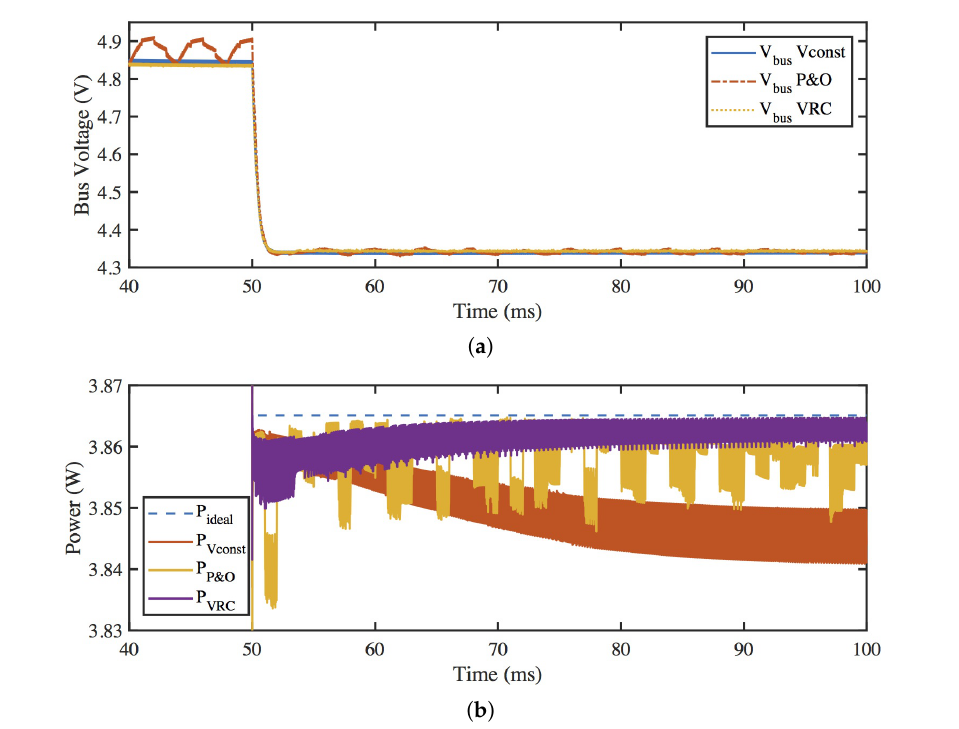
Figure 13. Waveforms of ( a ) the bus voltage and ( b ) the output power for different MPPT